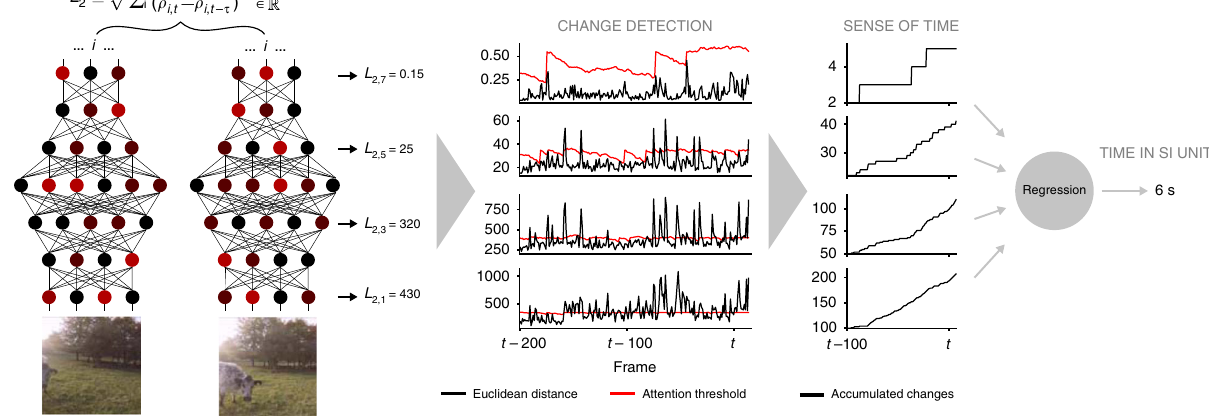
Fig. 2 Simpli fi ed depiction of the time estimation model. Salient changes in network activation driven by video input are accumulated and transformed into standard units for comparison with human reports. The bottom left shows two consecutive frames of video input. The connected coloured nodes depict network structure and activation patterns in each layer in the classi fi cation network for the inputs. L 2 gives the Euclidean distance between network activations to successive inputs for a given network layer (layers conv2, pool5, fc7, output). Neurons across the hierarchical layers of the classi fi cation network are differentially responsive to feature complexity in images, with higher layers more responsive to object-like archetypes and lower layers to primitive features like edges or contours (e.g. see Fig. 4 in ref. 41 ). In the Change Detection stage, the value of L 2 for a given network layer is compared to a dynamic threshold (red line). When L 2 exceeds the threshold level, a salient perceptual change is determined to have occurred, a unit of subjective time is determined to have passed and is accumulated to form the base estimate of time. Support vector regression is applied to convert this abstract time estimate into standard units (in s) for comparison with human reports